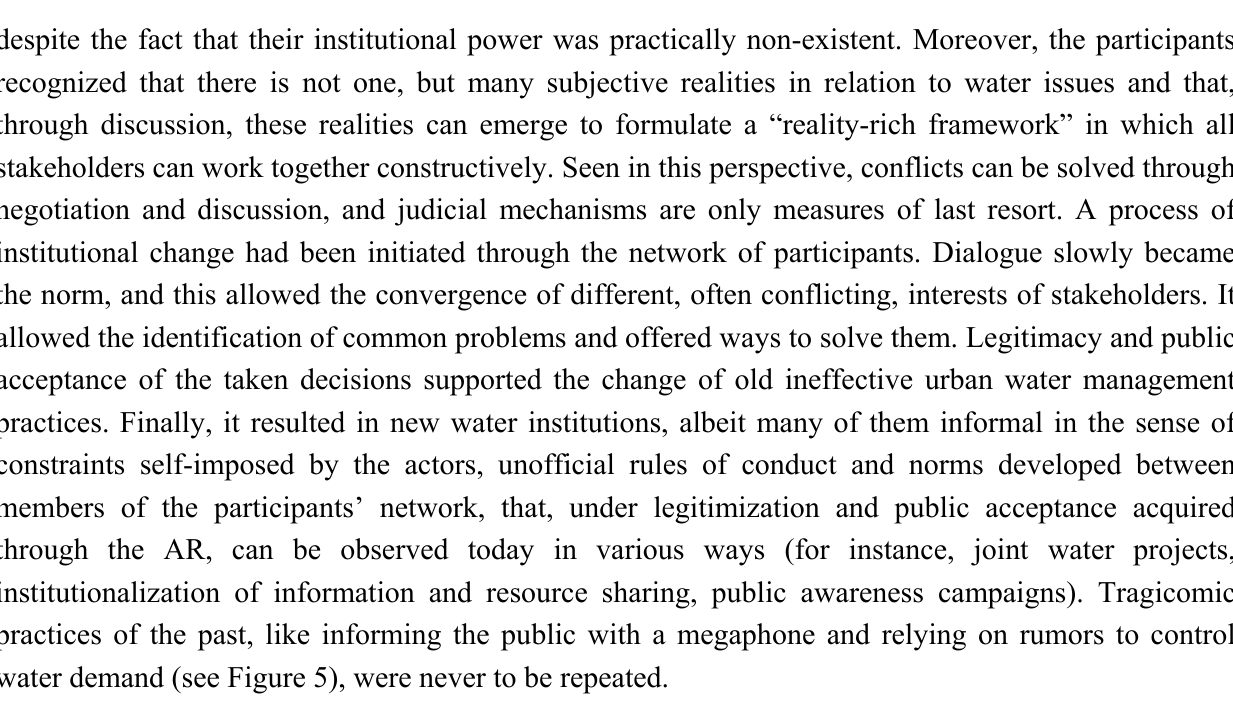
Figure 5. Practices of the